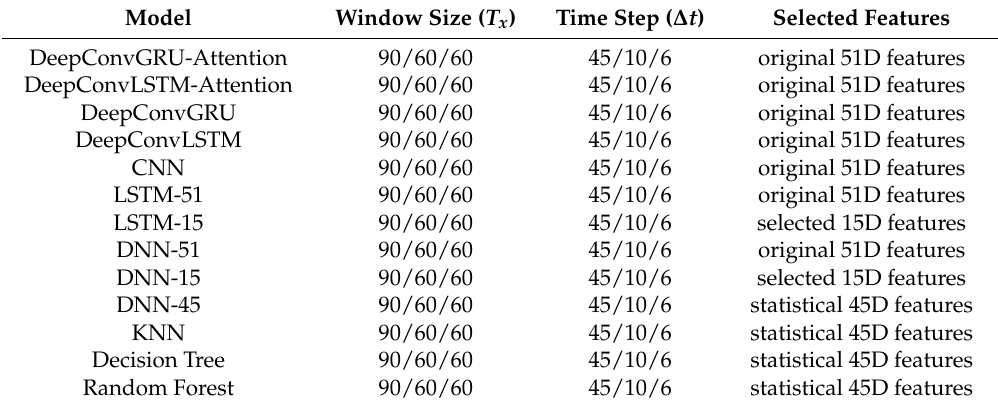
Table 3. Hyper-parameters of models on Ocslab driving dataset.